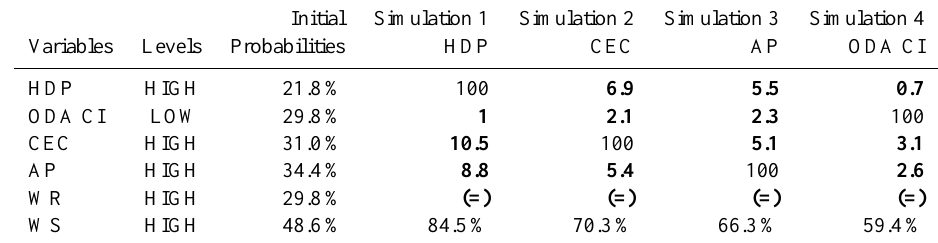
Table 2. General model – water supply simulations. In bold, positive variations of probabilities.